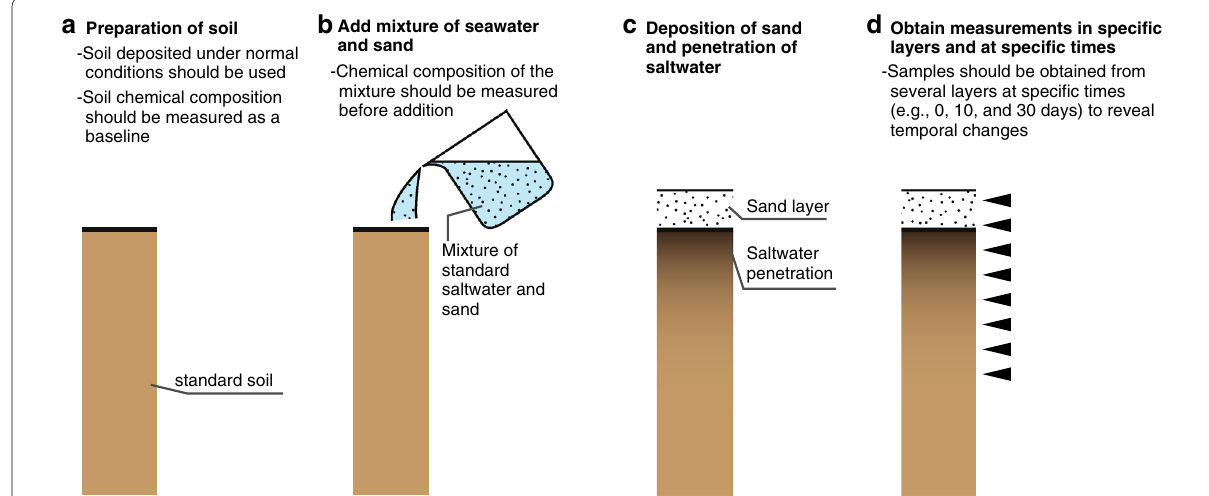
Fig. 3 A simple example of an infiltration experiment. The dark color in c and d indicates penetration of the soil column by saltwater. Black arrows in d indicate sampling